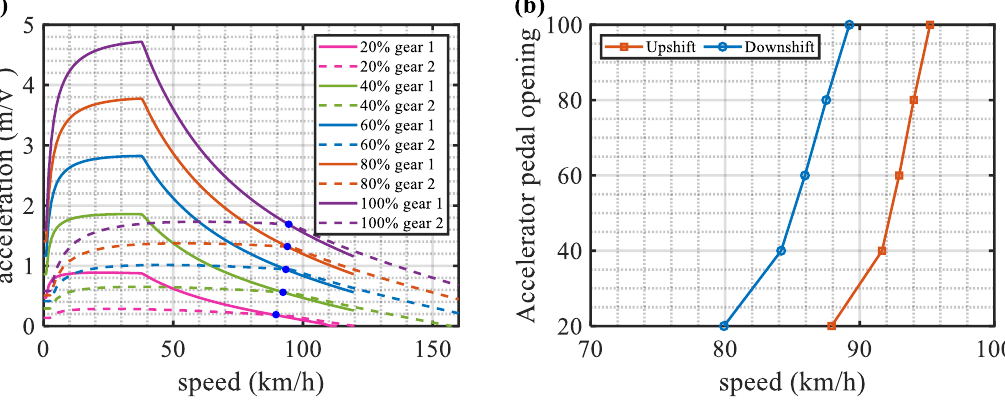
Figure 7. Dynamic shifting strategy: ( a ) vehicle acceleration curves; ( b ) dynamic shift curves. The dynamic shifting curve obtained by the above method is the upshift curve. The downshift curve was also chosen to be another curve when the shifting speed was lower than the upshift curve. In this paper, a convergent shift rule was used to determine the dynamic downshift curve. This meant that the magnitude of the downshift speed delay decreased with the increase in the accelerator pedal opening.